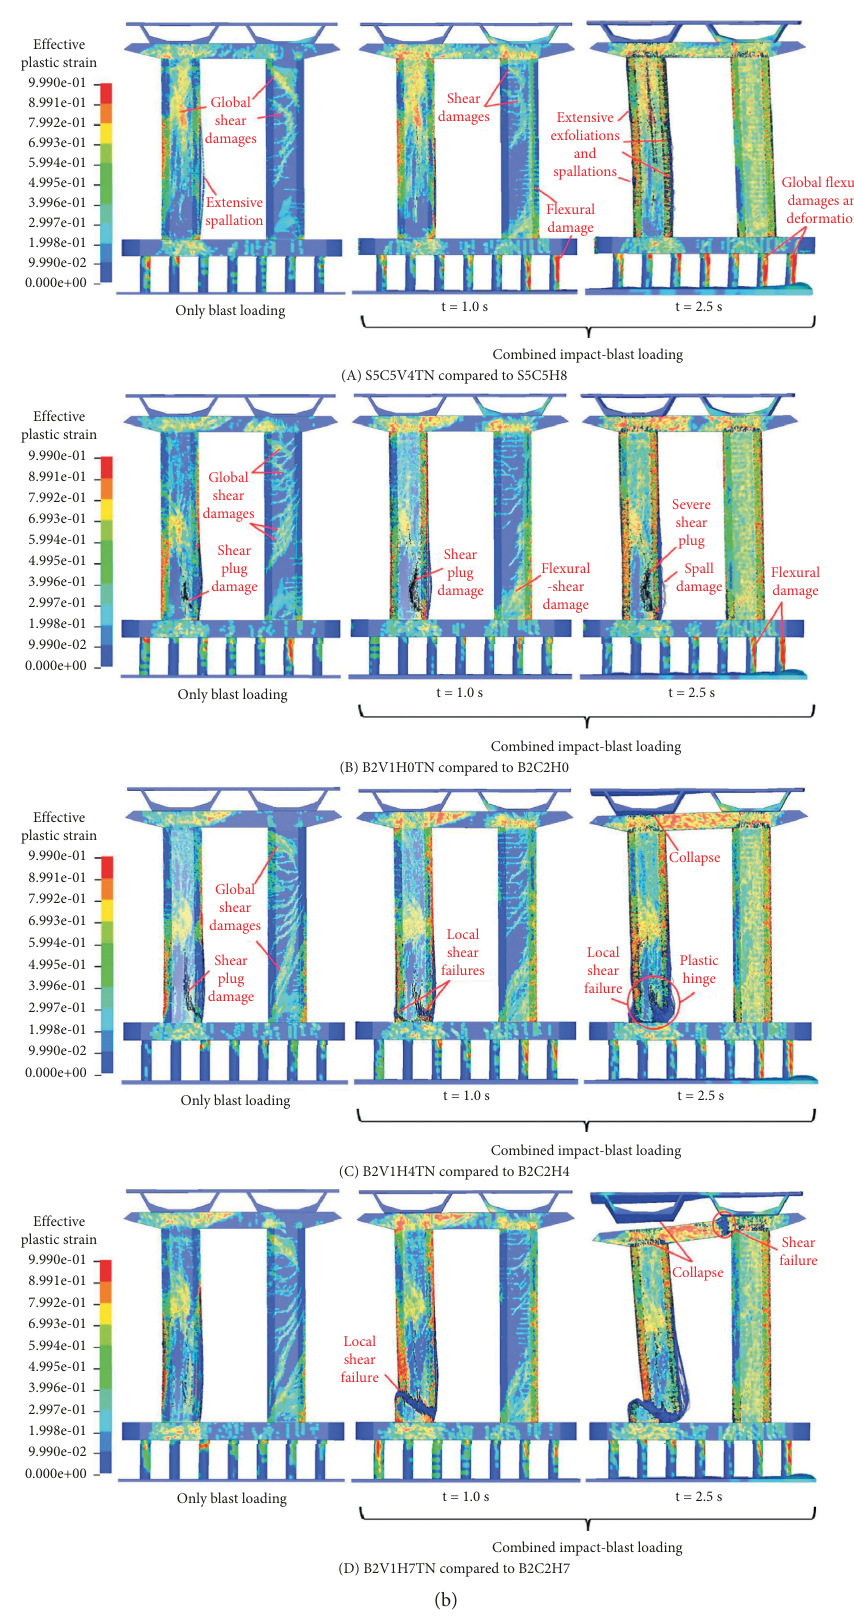
Figure 10: Summary of FEA numerical simulation failure modes for RC bridge column [6]: (a) different location of loading; (b) only-blast and combined loading